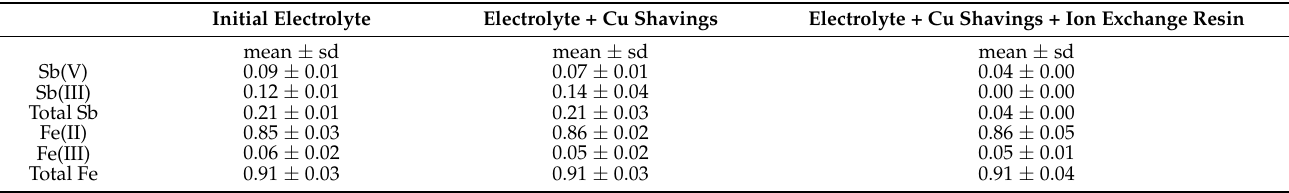
Table 2. Average concentrations (g L − 1 ) of Sb and Fe species in samples of initial electrolyte, treated electrolyte with Cu shavings and treated electrolyte with Cu shavings and ion exchange resin in the industrial Sb/Bi removal plant. The results of the concentrations are expressed as mean ± standard deviation ( n =